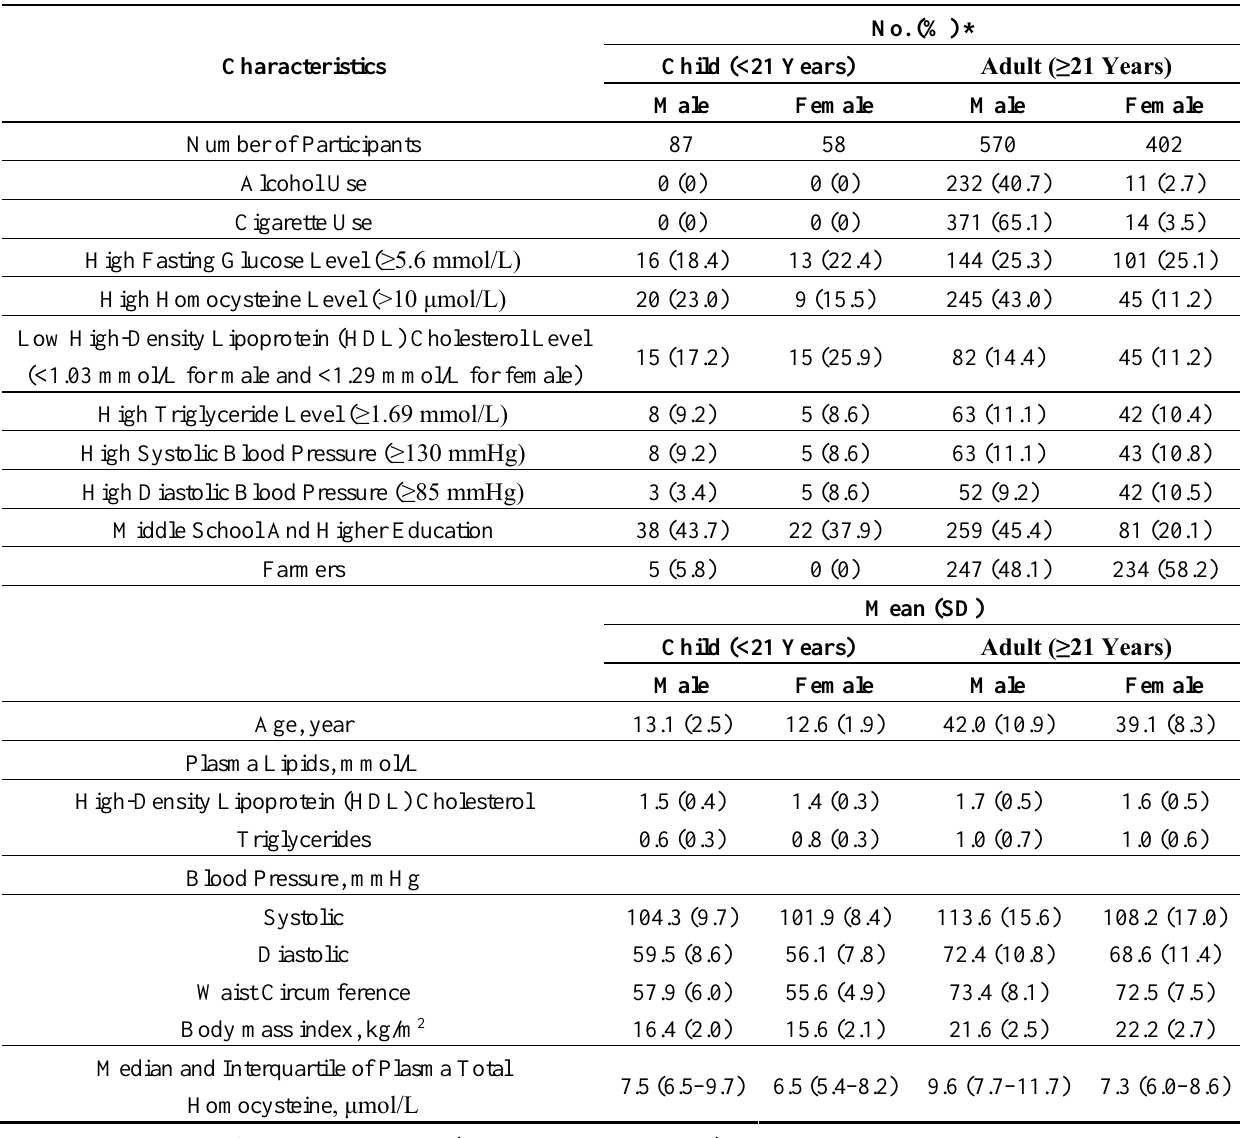
Table 1. Characteristics of participants from the Anqing twin cohort by age and